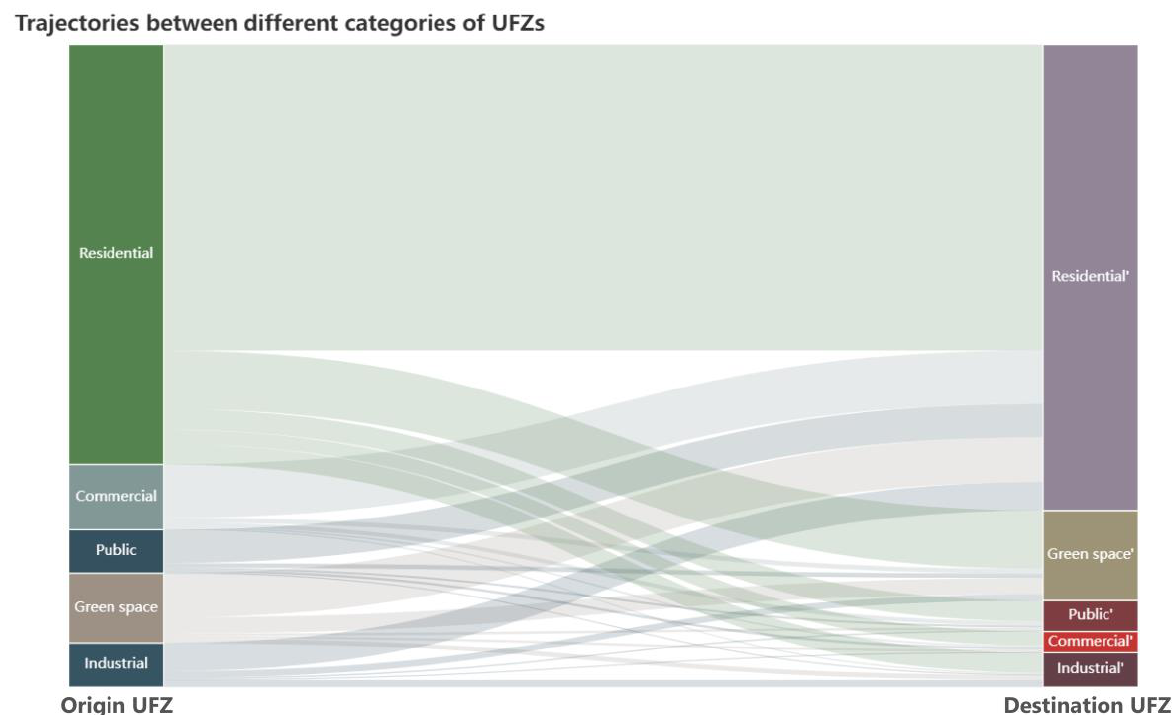
Figure 14. Sankey diagram of mobility flow between UFZs in